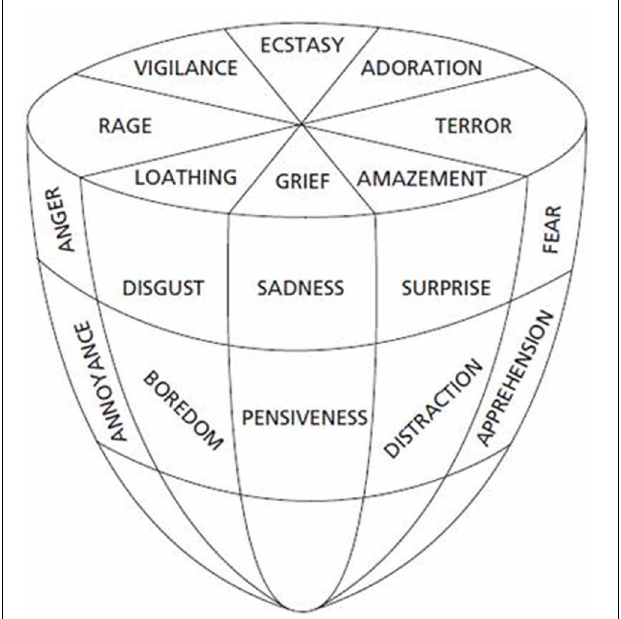
FIGURE 1 | Plutchik’s “cone model” of emotion (adapted from Plutchik,